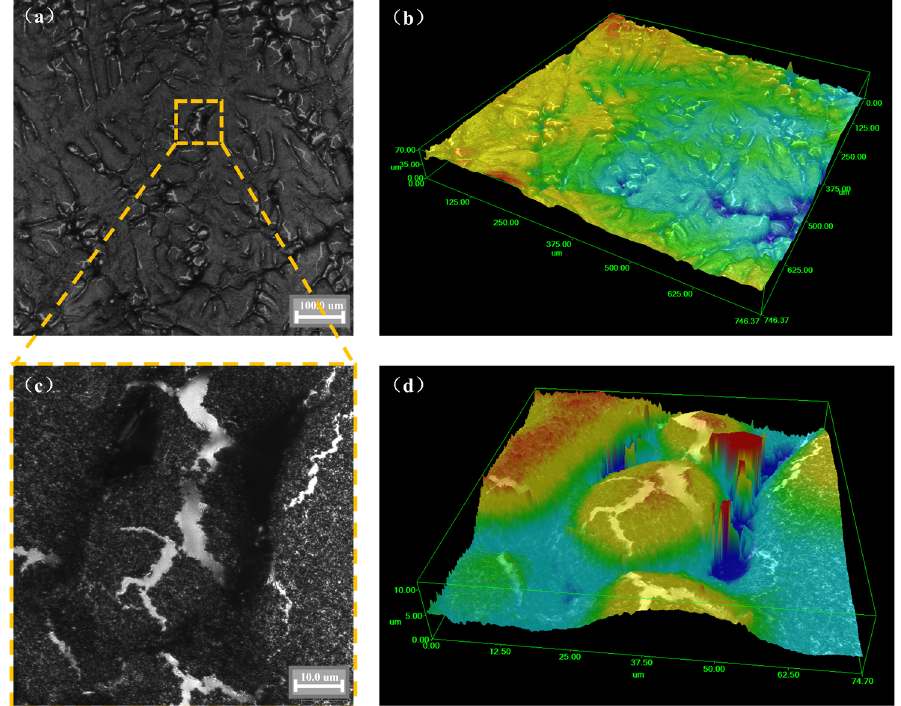
Figure 7. Three-dimensional surface morphology of AA6111 alloy: ( a - b ) ×500, ( c - d ) ×2000.